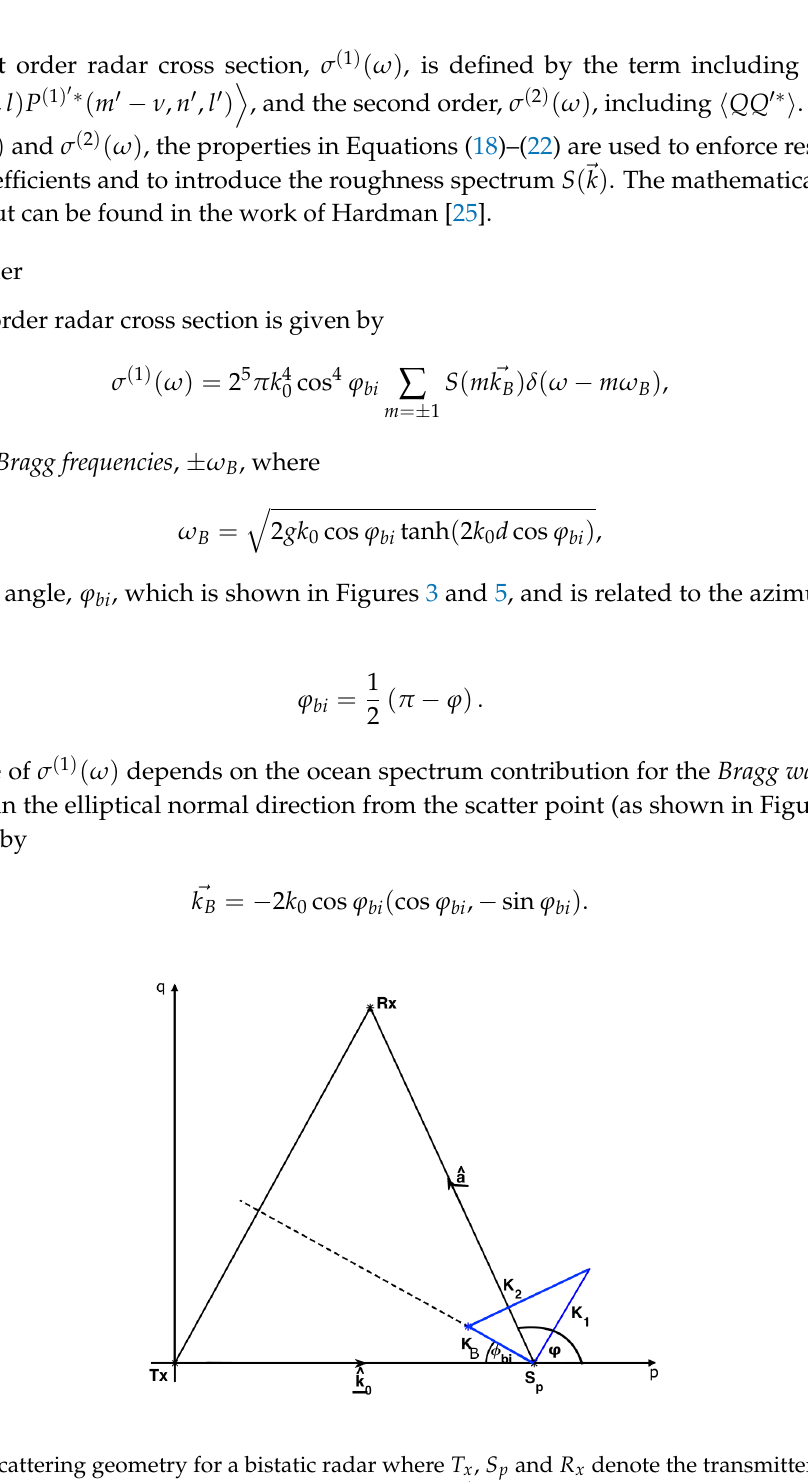
Figure 5. Scattering geometry for a bistatic radar where T x , S p and R x denote the transmitter, scatter patch and receiver respectively, ϕ bi is the bistatic angle, (cid:126) k 0 is the radar wavevector and, p and q are spatial wavenumbers, with p in the direction of the emitted radio